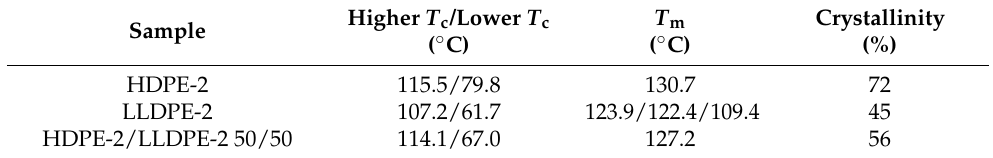
Table 8. DSC data of the HDPE-2/LLDPE-2 50/50 blend compared with the neat components.